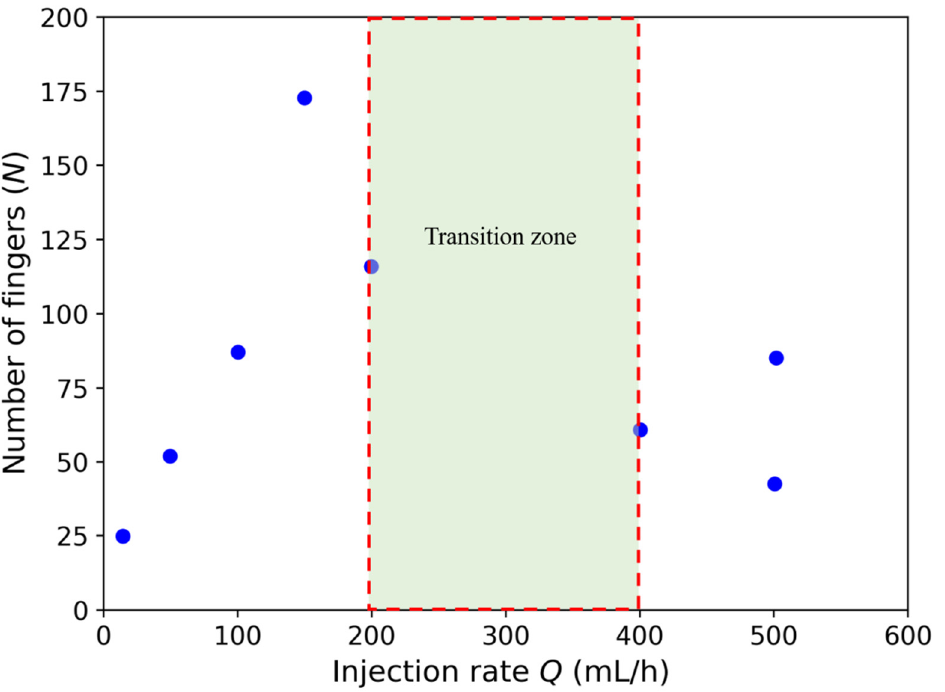
Figure 4. Relationship of injection rate Q with respect to the number of fingers N at a citric acid concentration c = 15 wt% (when the volume of the injected aqueous citric acid solution is 2 mL and the gap width b is 0.4 mm). The transition zone represents the region at which the fingers begin to merge.